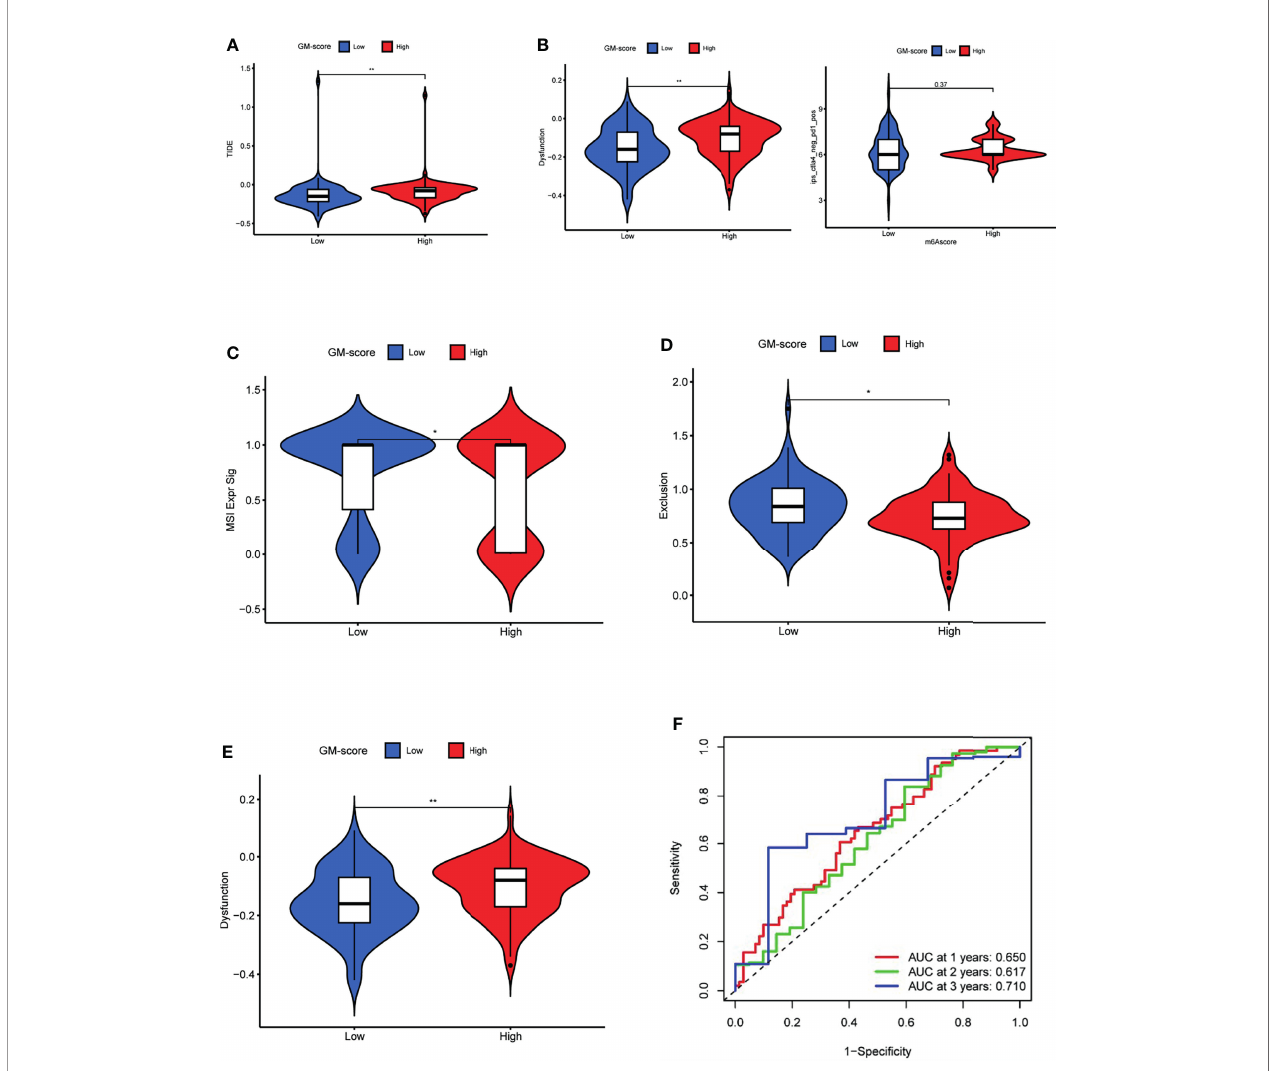
FIGURE 6 | GM-score in the role of immunotherapy. (A) TIDE score of the 2 GM-score subgroups. (B) Effectiveness of immunotherapy in GM-score subgroups. (C) MSI score of the 2 GM-score subgroups. (D) T-cell exclusion score of the 2 GM-score subgroups. (E) T-cell dysfunction score of GM-score subgroups. (F) ROC curves of GM-score for predicting 1-, 2-, and 3-year survival. *, **, and *** indicate p = < 0.05, < 0.01, and < 0.001,